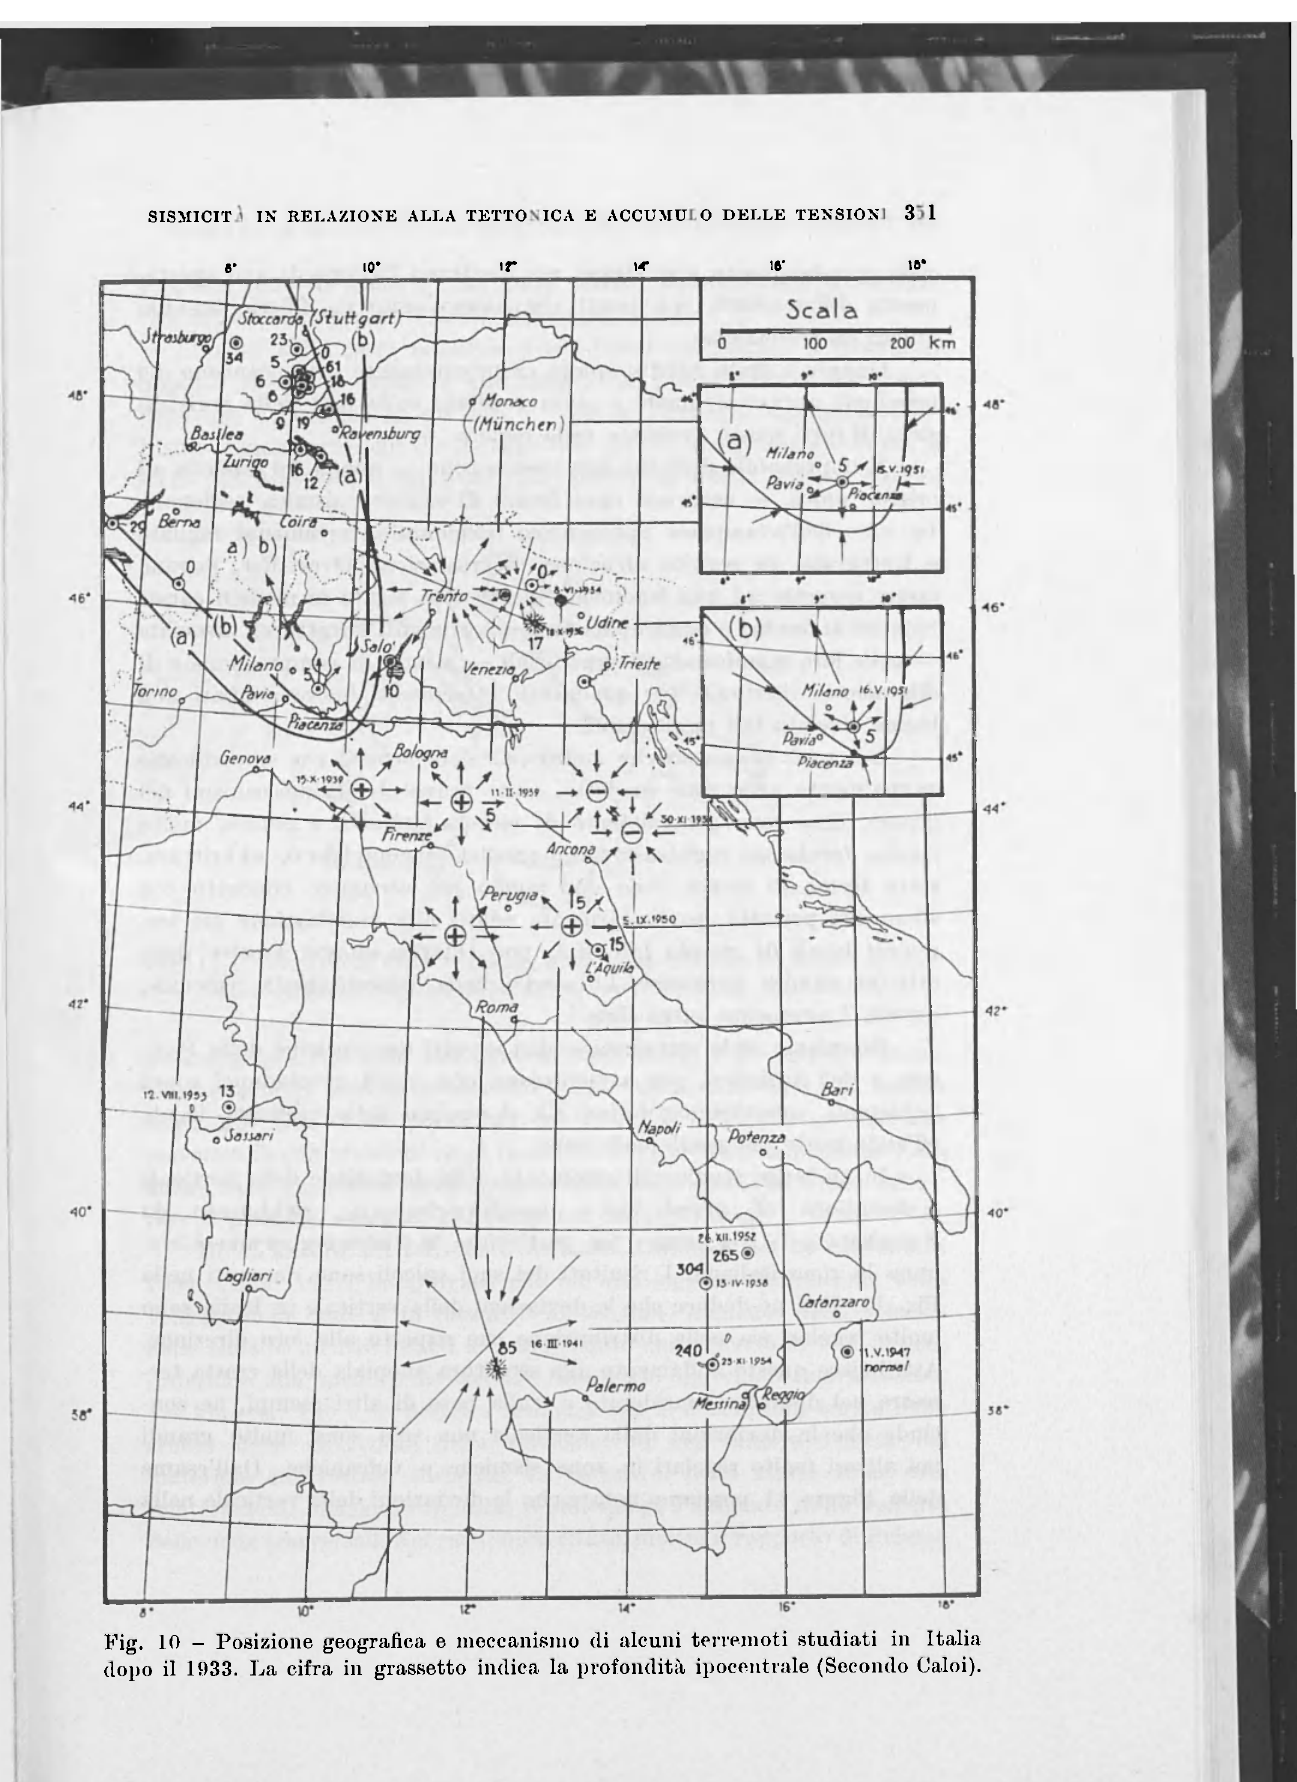
Fig. 10 - Posizione geografica e meccanismo di alcuni terremoti studiati in Italia dopo il 1933. La cifra in grassetto indica la profondità ipocentrale (Secondo